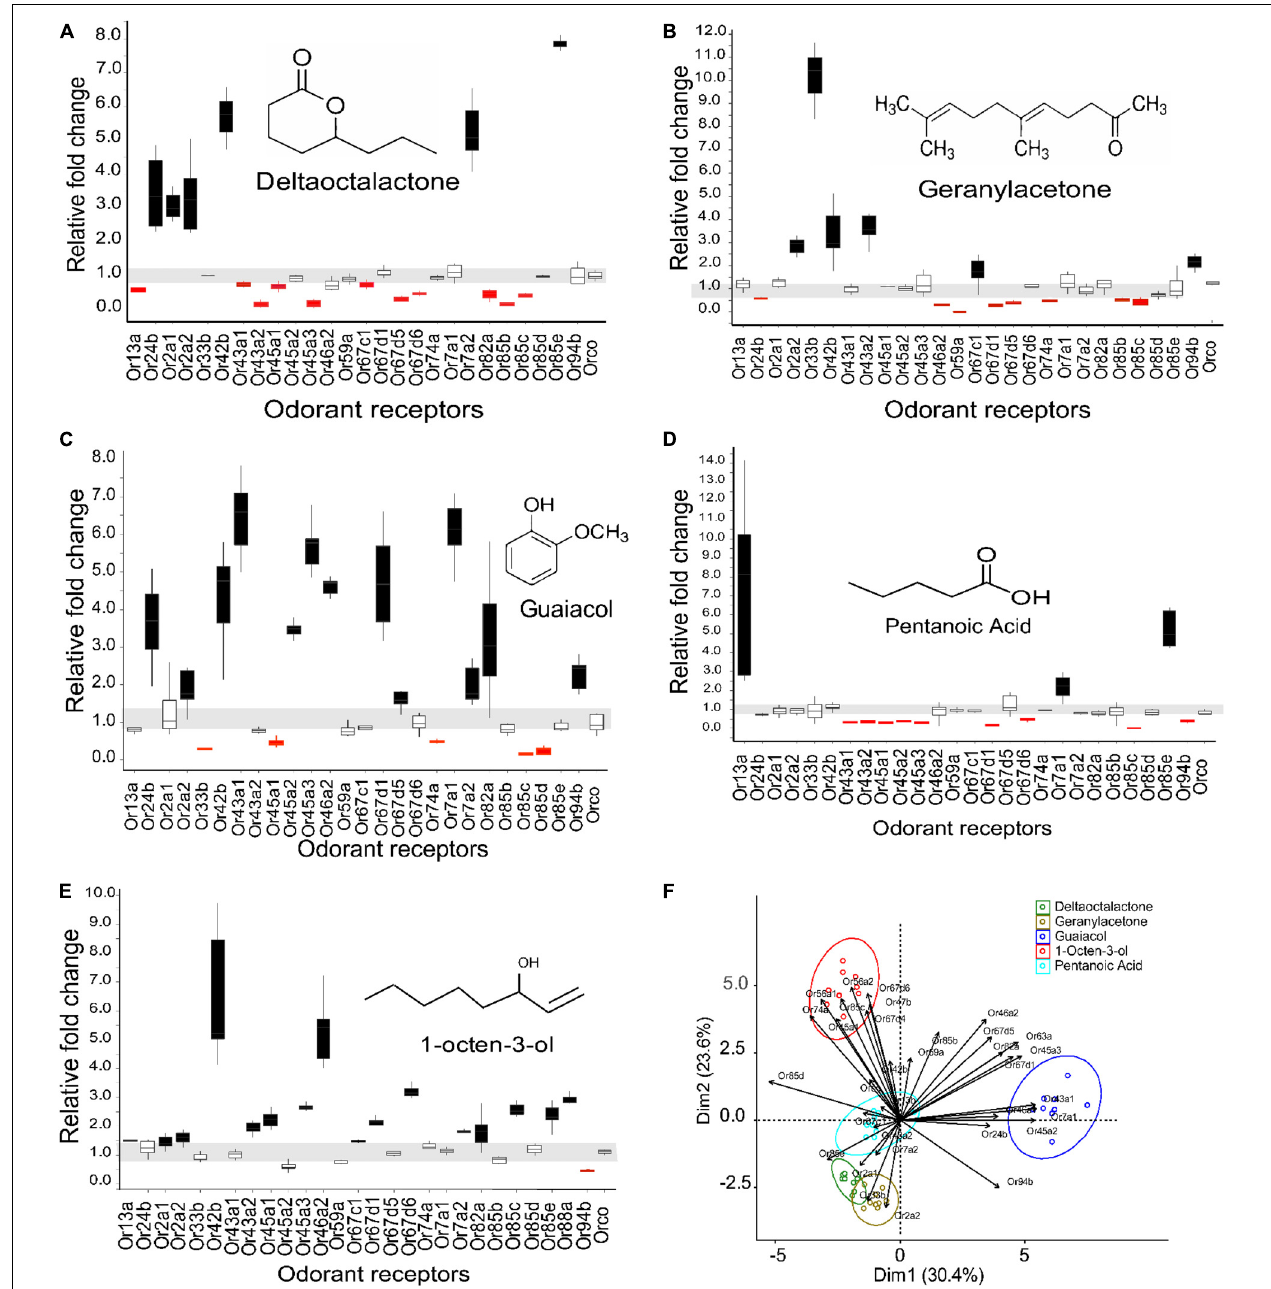
FIGURE 2 | Expression pattern of G . f . fuscipes odorant receptors after exposure to WRB components and 1-octen-3-ol. The horizontal gray zone corresponds to OR mRNA transcript values that were not affected. (A) Expression pattern of ORs to δ -octalactone. (B) Expression pattern of ORs to geranylacetone. (C) Expression pattern of ORs to guaiacol. (D) Expression patterns of ORs to pentanoic acid. (E) Expression pattern of ORs to 1-octen-3-ol. (F) PCA plot showing the clustering pattern of the five tested ligands based on the fold change of the mRNA of ORs (A–E) . The PCA explained 53.6% of the total variation. ORs that do not fall into one of the cluster circles (F) show that the mRNA transcript level was not affected by the odorant exposure. The graphs and the statistics were generated using R software21 ( version 3.5.1 ) , www.R-project.org. ( PCA ) was performed using two R packages called “FactoMineR” and “Factoextra” (Kassambara, 2017).